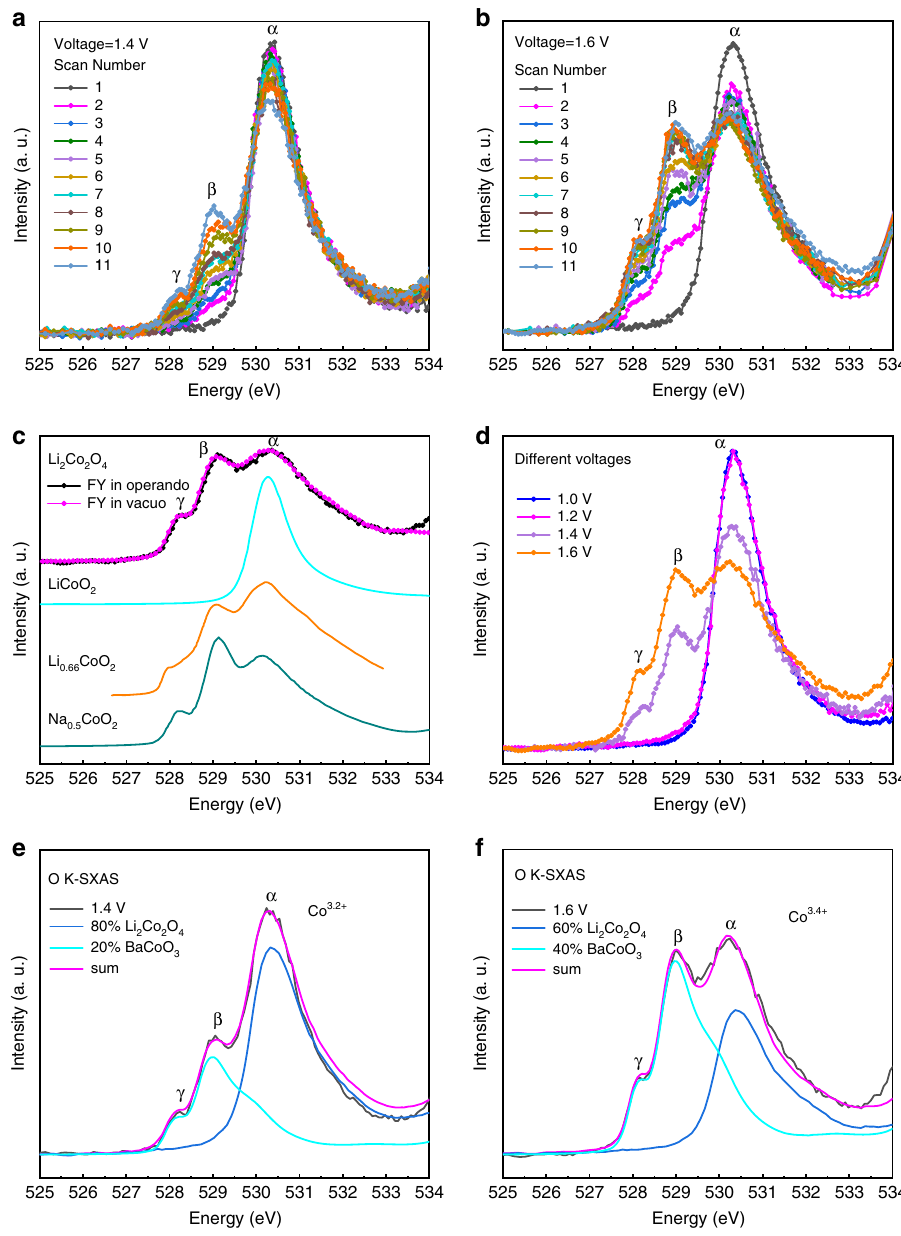
Fig. 2 In operando O – K SXAS spectra of Li 2 Co 2 O 4 . a , b O – K SXAS spectra of Li 2 Co 2 O 4 in operando as a function of the number of scans (2 min for each scan) at applied voltages of 1.4 and 1.6 V, respectively. c Comparison of the spectra during the OER (black circles, in operando) and after the OER (magenta circles, in vacuo). Also included are the spectra of LiCoO 2 (cyan line) with the low-spin Co 3 + state, mixed-valent Co oxide Li 0.66 CoO 2 (orange line, from Ref. 29 ), and Na 0.5 CoO 2 (dark cyan line, from Ref. 30 ) with the same 90° Co – O – Co bond angle. d Spectra of Li 2 Co 2 O 4 at different applied voltages. e , f Experimental (black lines) and simulated (magenta lines) spectra of Li 2 Co 2 O 4 under an applied voltage of 1.4 and 1.6 V, respectively, with the simulations being constructed as weighted sums of the spectra of the as-prepared Li 2 Co 2 O 4 (blue) representing the low-spin Co 3 + state and of BaCoO 3 (cyan, from Ref. 27 ) representing the low-spin Co 4 + con fi